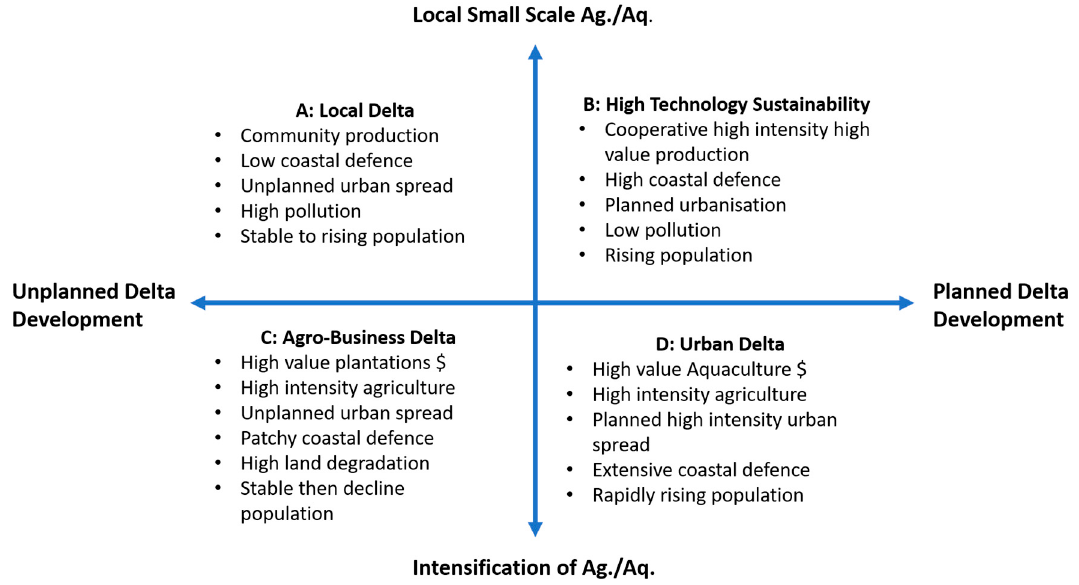
Figure 4. Four future scenarios for the SBR region aligned against axes of uncertainty surrounding the intensity of agriculture and aquaculture production and the degree to which delta development is planned or unplanned. A full description of each narrative is given in supplementary in- formation.